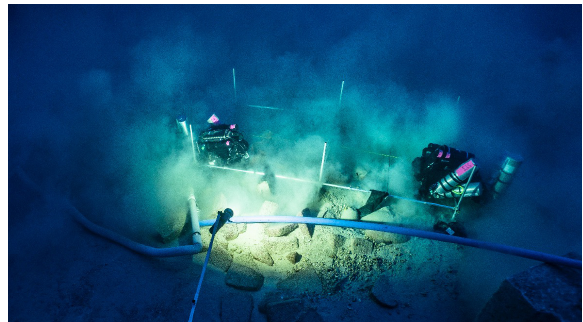
Figure 2: The bubble tripod and two cement blocks. pump immersed at 20 meters), 2x2 meters quadrat, photogram- metric monitoring, removal of artifact and appearance of lower layers.